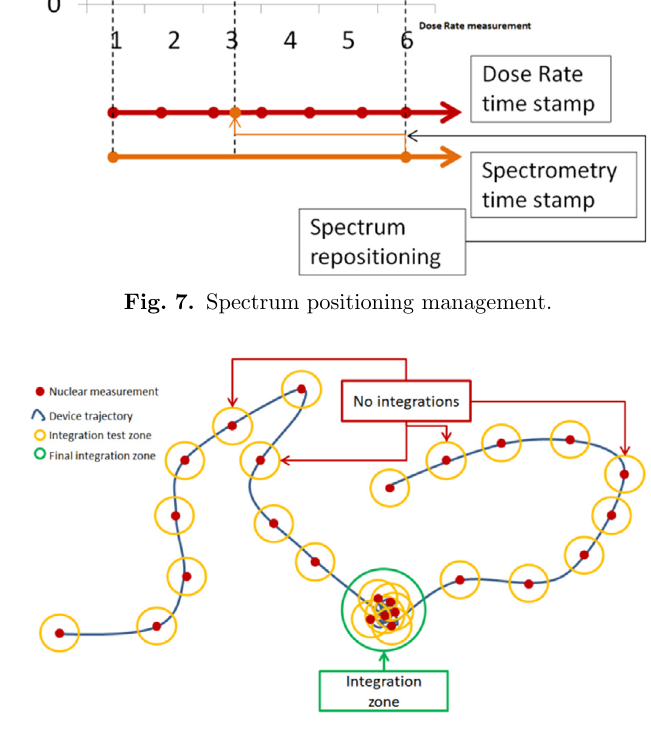
Fig. 8. Radioactive measurements